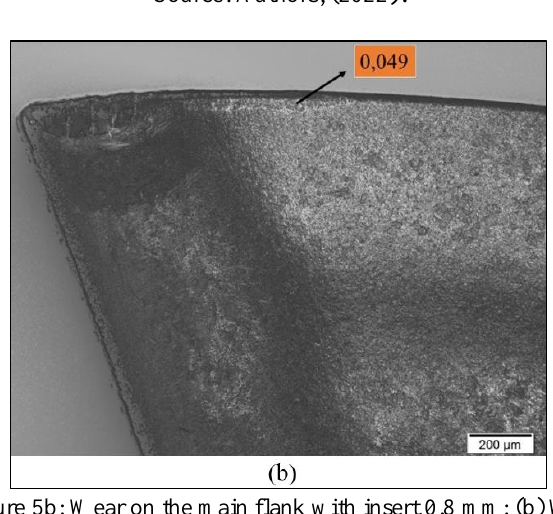
Figure 5b: Wear on the main flank with insert 0,8 mm: (b) With sealant.